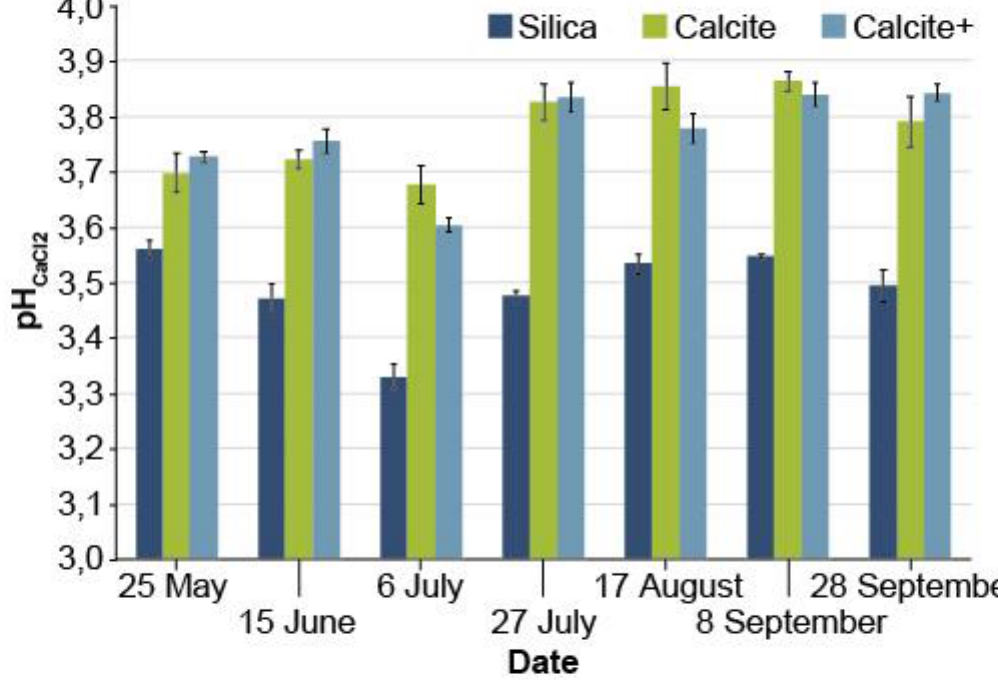
Figure 2. Evolution of pH CaCl2 of peat growth substrate during the growing season of white spruce seedlings (2+0), depending on the covering material (silica: 29 g/cavity, calcite: 24 g/cavity and calcite+: 31 g/cavity).